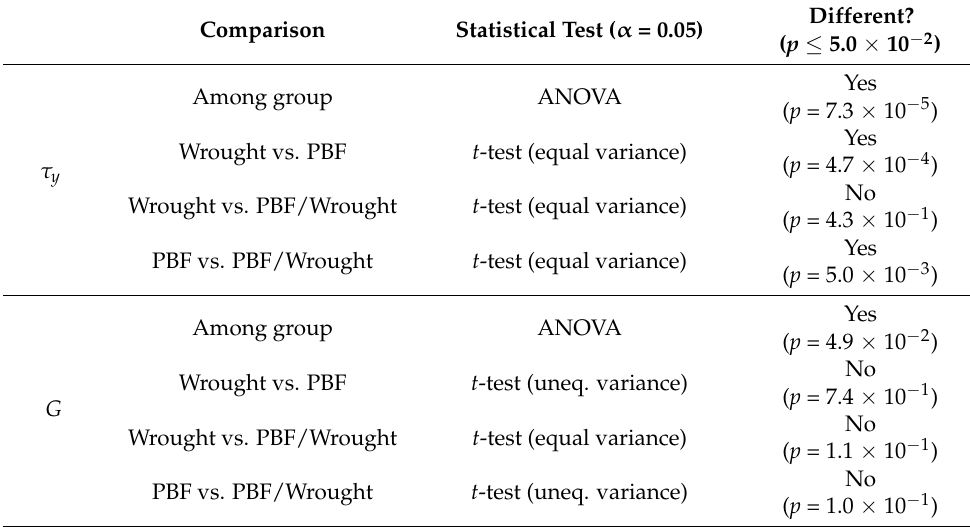
Table 5. Statistical analysis of torsion specimens.